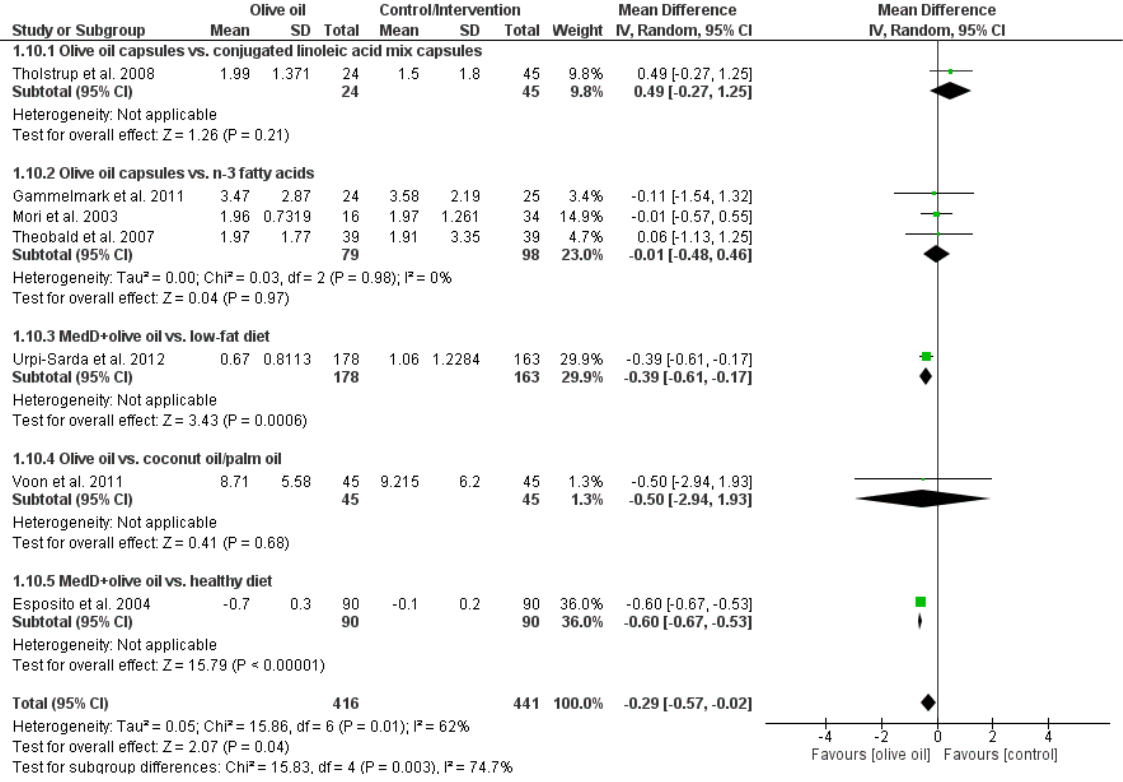
Figure 4. Effects of olive oil on interleukin-6 (pg/mL). Forest plot showing pooled mean differences with 95% confidence intervals (CI) for seven randomized controlled diets. For each study, the shaded square represents the point estimate of the intervention effect. The horizontal line joins the lower and upper limits of the 95% CI of these effects. The area of the shaded square reflects the relative weight of the study in the respective meta-analysis. The diamond at the bottom of the graph represents the pooled MD with the 95% CI for all study groups. MedD = Mediterranean diet.